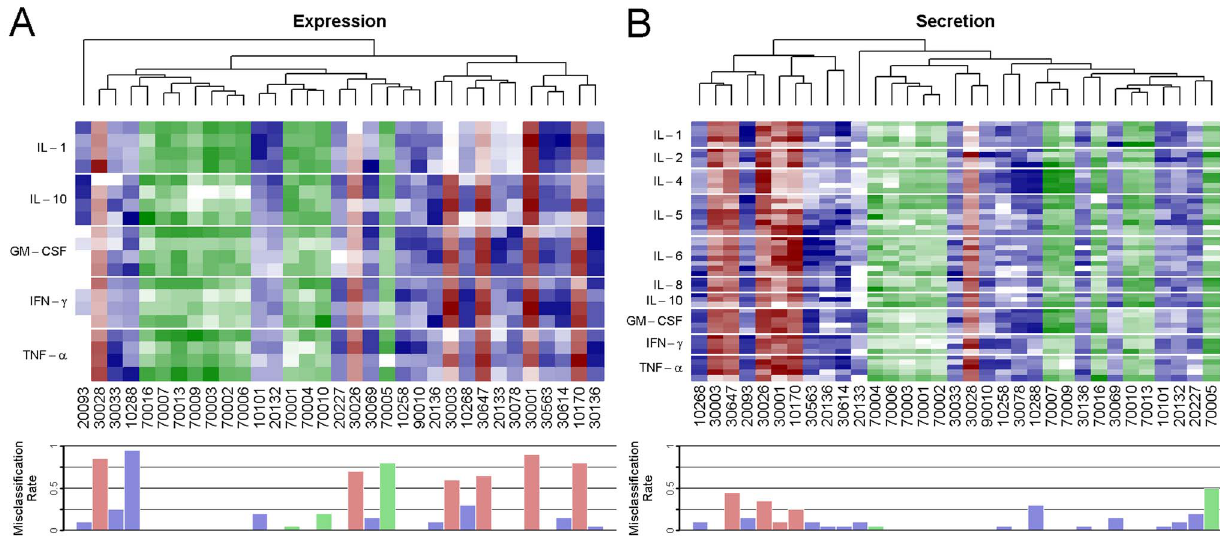
Figure 5. Hierarchical clustering of patients by gene expression or cytokine secretion. Control (green), acute (blue), and relapse (red) patients were clustered hierarchically by Euclidean distance in their scaled gene expression (A) or cytokine secretion (B) profiles (see Methods). Response variables are grouped by cytokine, indicated in the left margin, and values are indicated by luminosity. Misclassification rates for each patient after 20 model selection runs are indicated underneath the corresponding patient code (see Supporting Table S1).